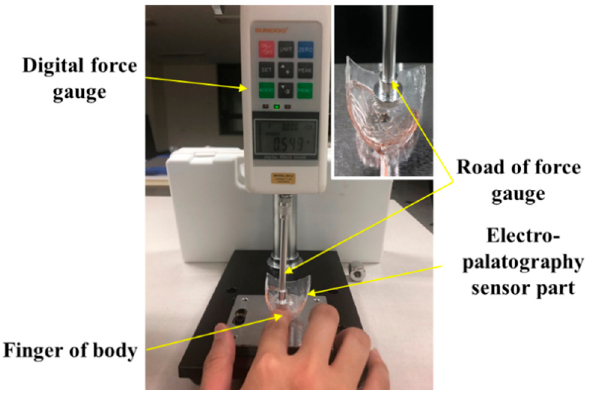
Figure 6. Experimental setup for the evaluation of the electropalatography sensor according to the force application.